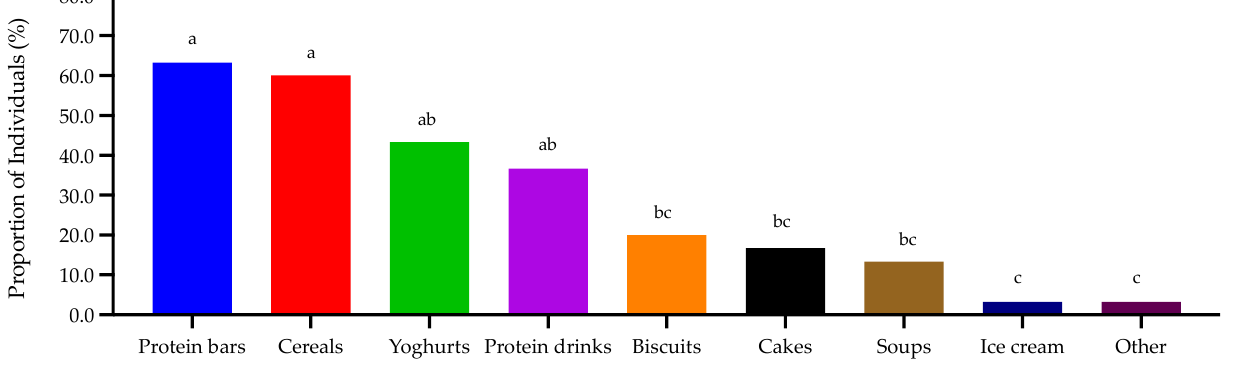
Figure 8. Consumers’ ( n = 30) recalled perception ratings of protein-fortified products relating to taste/flavour and texture from a five-point category scale (data reported as percentages). 4. Discussion 4.1. Initial Literature and Market Review on Protein-Fortified Products The key themes from the initial product review related to familiar and popular prod- ucts mainly in liquid or snack format with differences in serving size, protein content and protein sources; accordingly, making comparisons between products challenging. More- over, the quality of the protein source is an important consideration for an ageing popu- lation and vital to maximising benefits. Therefore, corresponding serving sizes may need to vary between protein sources to get the same measurable output. Animal derived pro- teins (e.g., whey protein) have advantages (such as a complete essential amino acid pro- file, digestibility, and muscle protein synthesis) over plant derived proteins [9]. More spe- cifically, whey proteins have been shown to trigger postprandial protein gain and muscle protein synthesis in an ageing population [8,11,55]. Overall, it is clear there is notable var- iability in terms of product types, protein sources (whey protein, milk and plant related or other) and protein quantity (0.9 – 50 g per 100 g or 100 mL) commonly utilised in protein- fortified matrices. Accordingly, next steps should focus on measurable and comparable